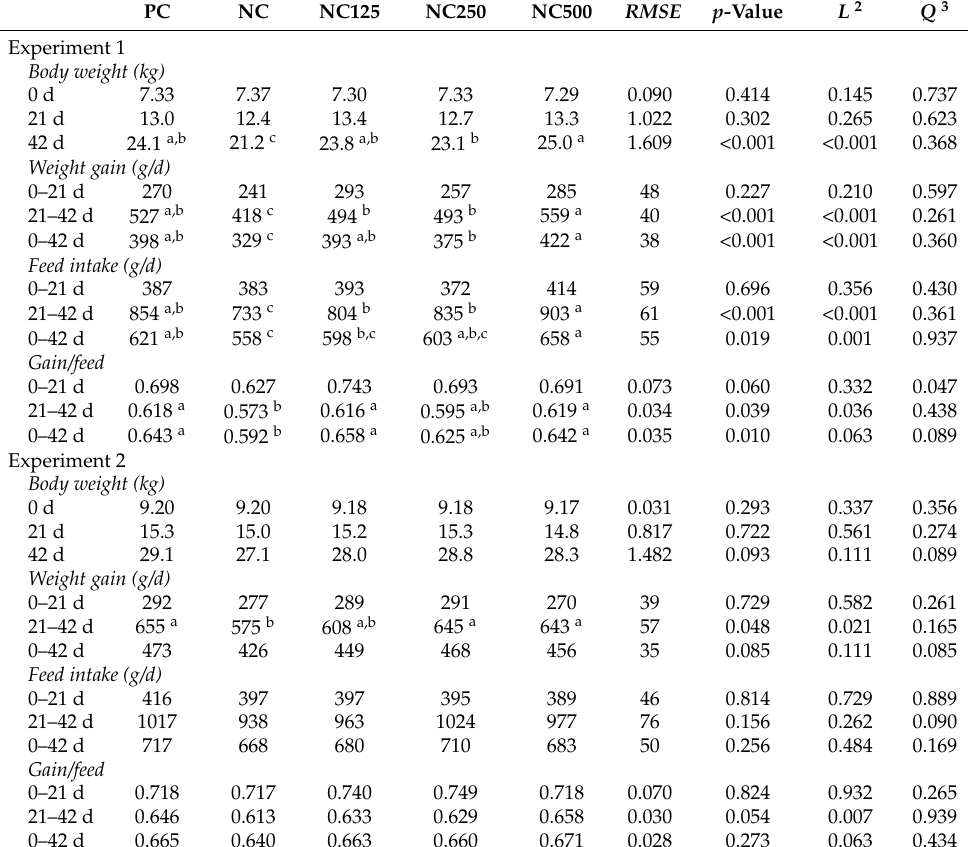
Table 2. Effect of 6-phytase supplementation to negative control diets on performance of weaned pigs 1